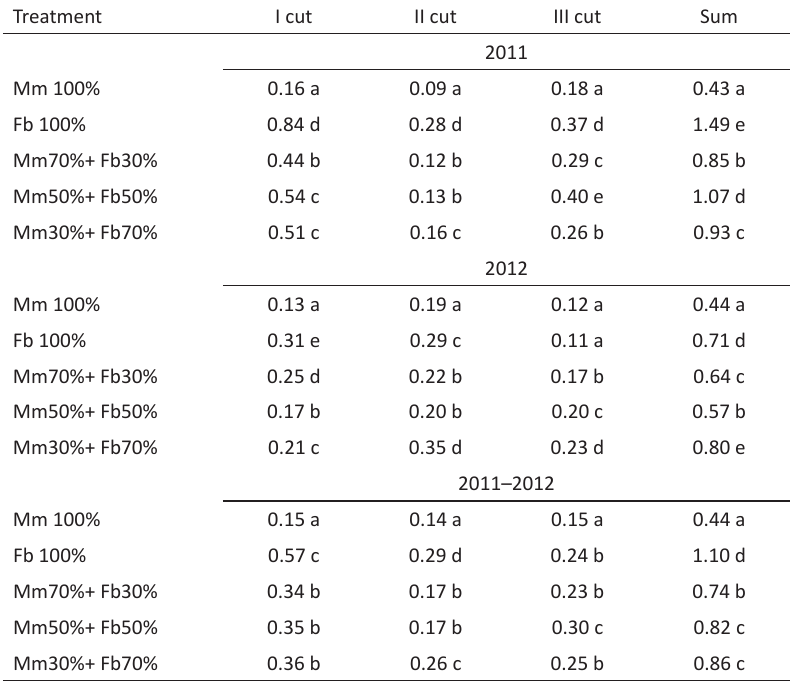
Table 4. Water soluble sugars yield (Mg ha -1 )